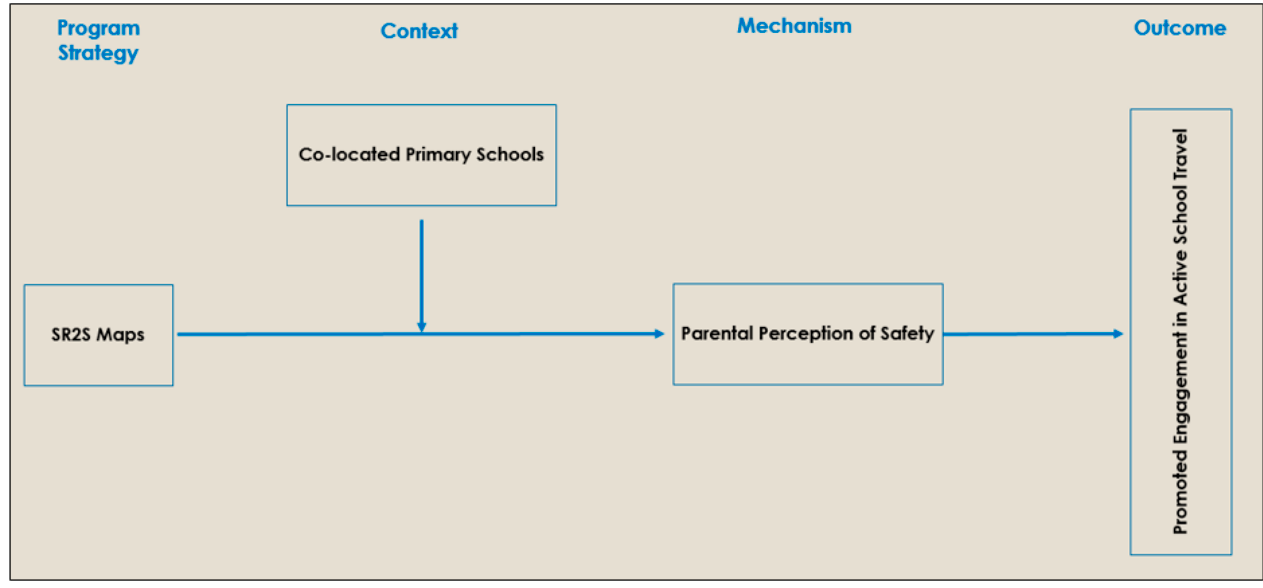
Figure 1. Example Preliminary CMOC.